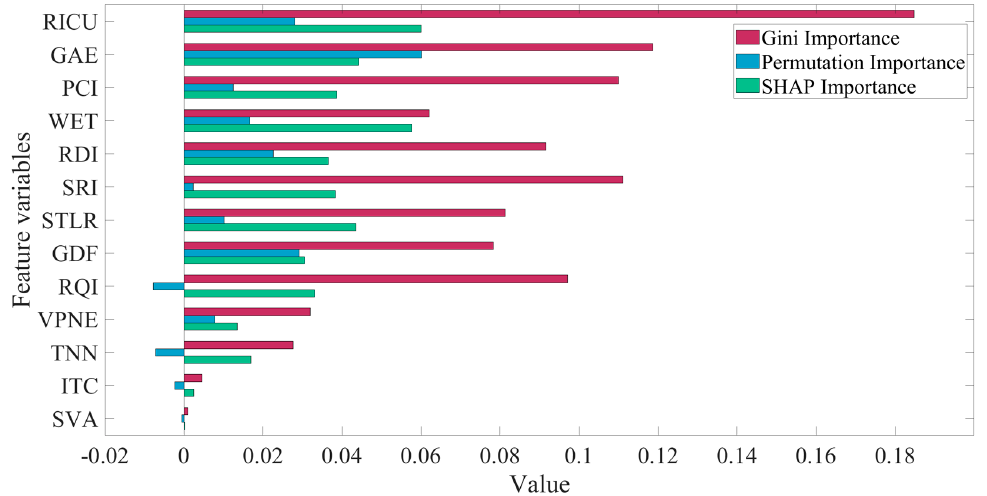
Figure 6. Feature importance (Gini importance, permutation importance, SHAP importance), sorted in accordance with the combined results of the three importance indicators.